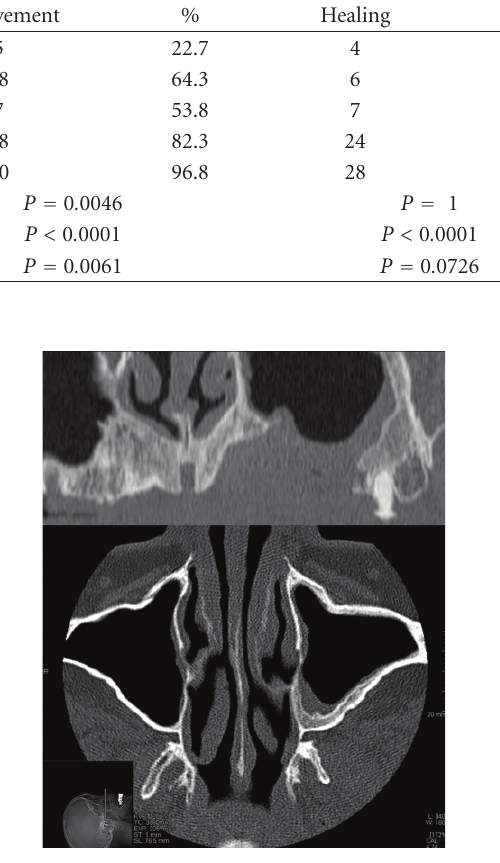
Figure 8: CT images showing the improvement and the healing of the maxillary sinus after the BRONJ treatment.